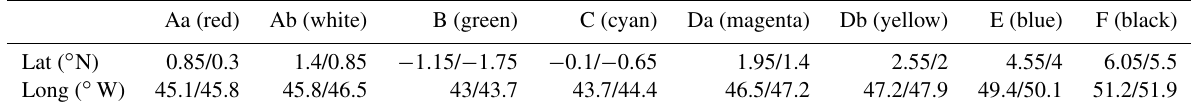
Table A1. Location of boxes surrounding internal tide generation hotspots. In brackets, the colour of the box is as in Fig. 7.